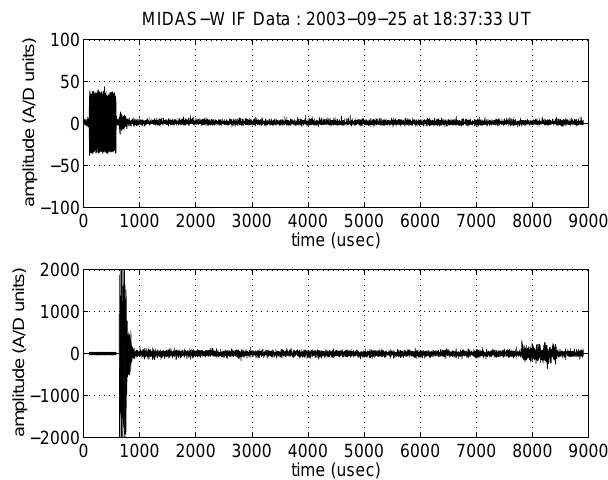
Fig. 3. An example of the source RF data (500kHz BW) for signal processing from incoherent scatter observations made with the Millstone Hill ISR. Both transmitter digitization and received signal channel data are shown prior to digital filtering and down- conversion. The outgoing radar signal is seen both directly in the TX channel (top) and as a leak through on the RX channel (bottom). Ground clutter and ionospheric returns are located in the main por- tion of the receive signal. A noise diode signal is injected for ab- solute system temperature calibration at the end of the sampling